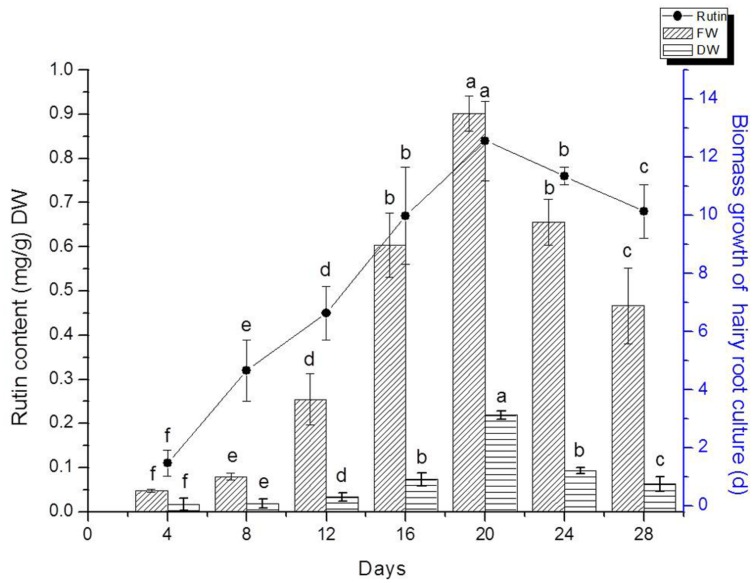
Hairy root line TB7 growth as a function of time, and kinetics of rutin production. Points represent mean ± SE of three replicates. Each experiment was performed in triplicate. Means with common letters are not significantly different at P < 0.05 according to Duncan’s multiple range test.